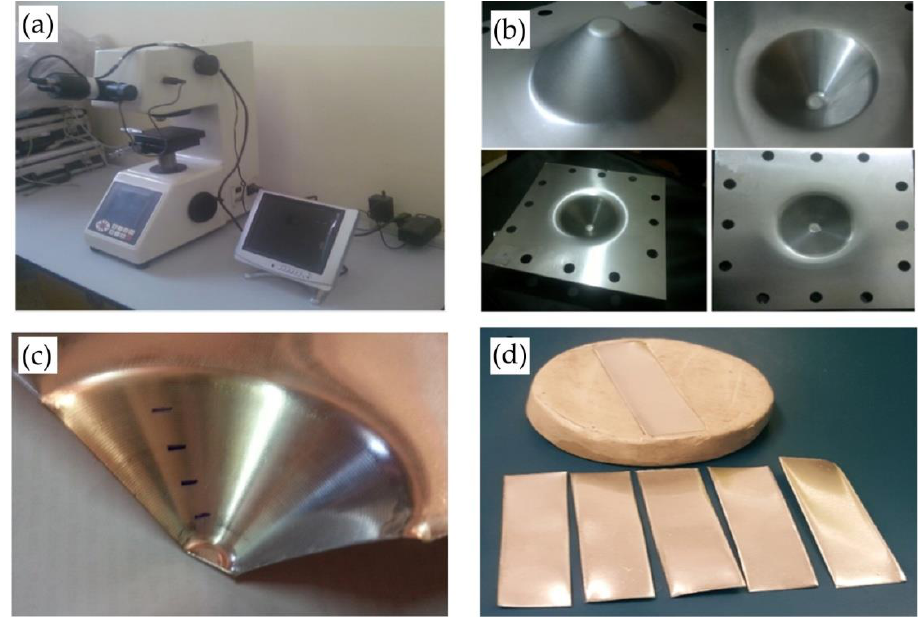
Figure 3. ( a ) Digital microhardness device, ( b ) formed parts, ( c ) three zones of hardness measure- ment, ( d ) hardness test sample of the formed part . ( d ) hardness test sample of the formed